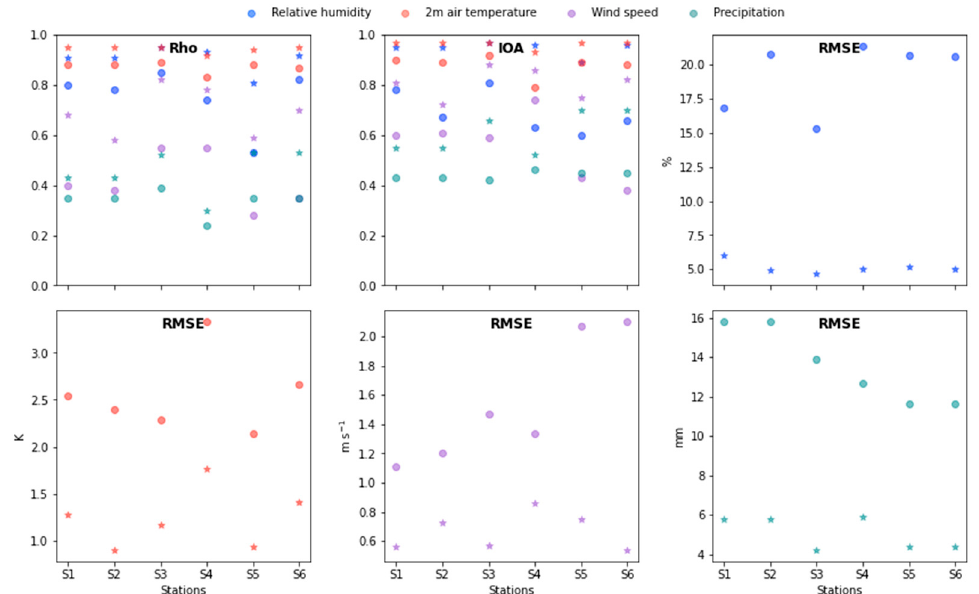
Figure 5. Statistical evaluation of the model performance for relative humidity, 2m air temperature, wind speed and precipitation for the selected 160 days (Section 2). The circles represent the results before the model was bias corrected and the stars show the results after the correction was applied. Notice that the RMSEs have different units depending on the variable.